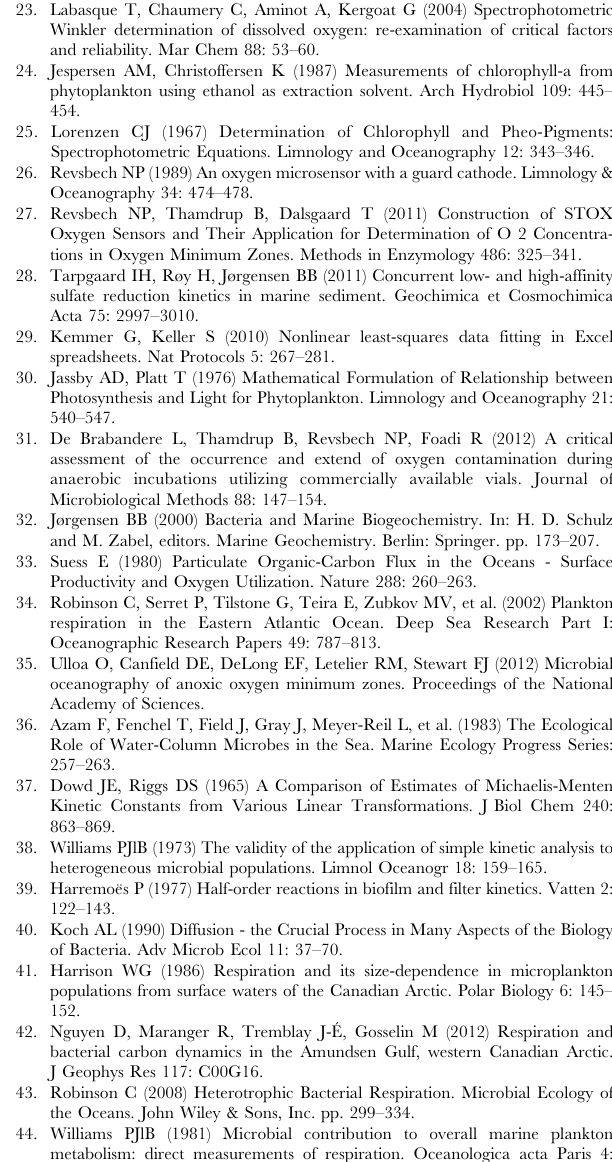
Text S2 Comparison and assessment of the use of different kinetic